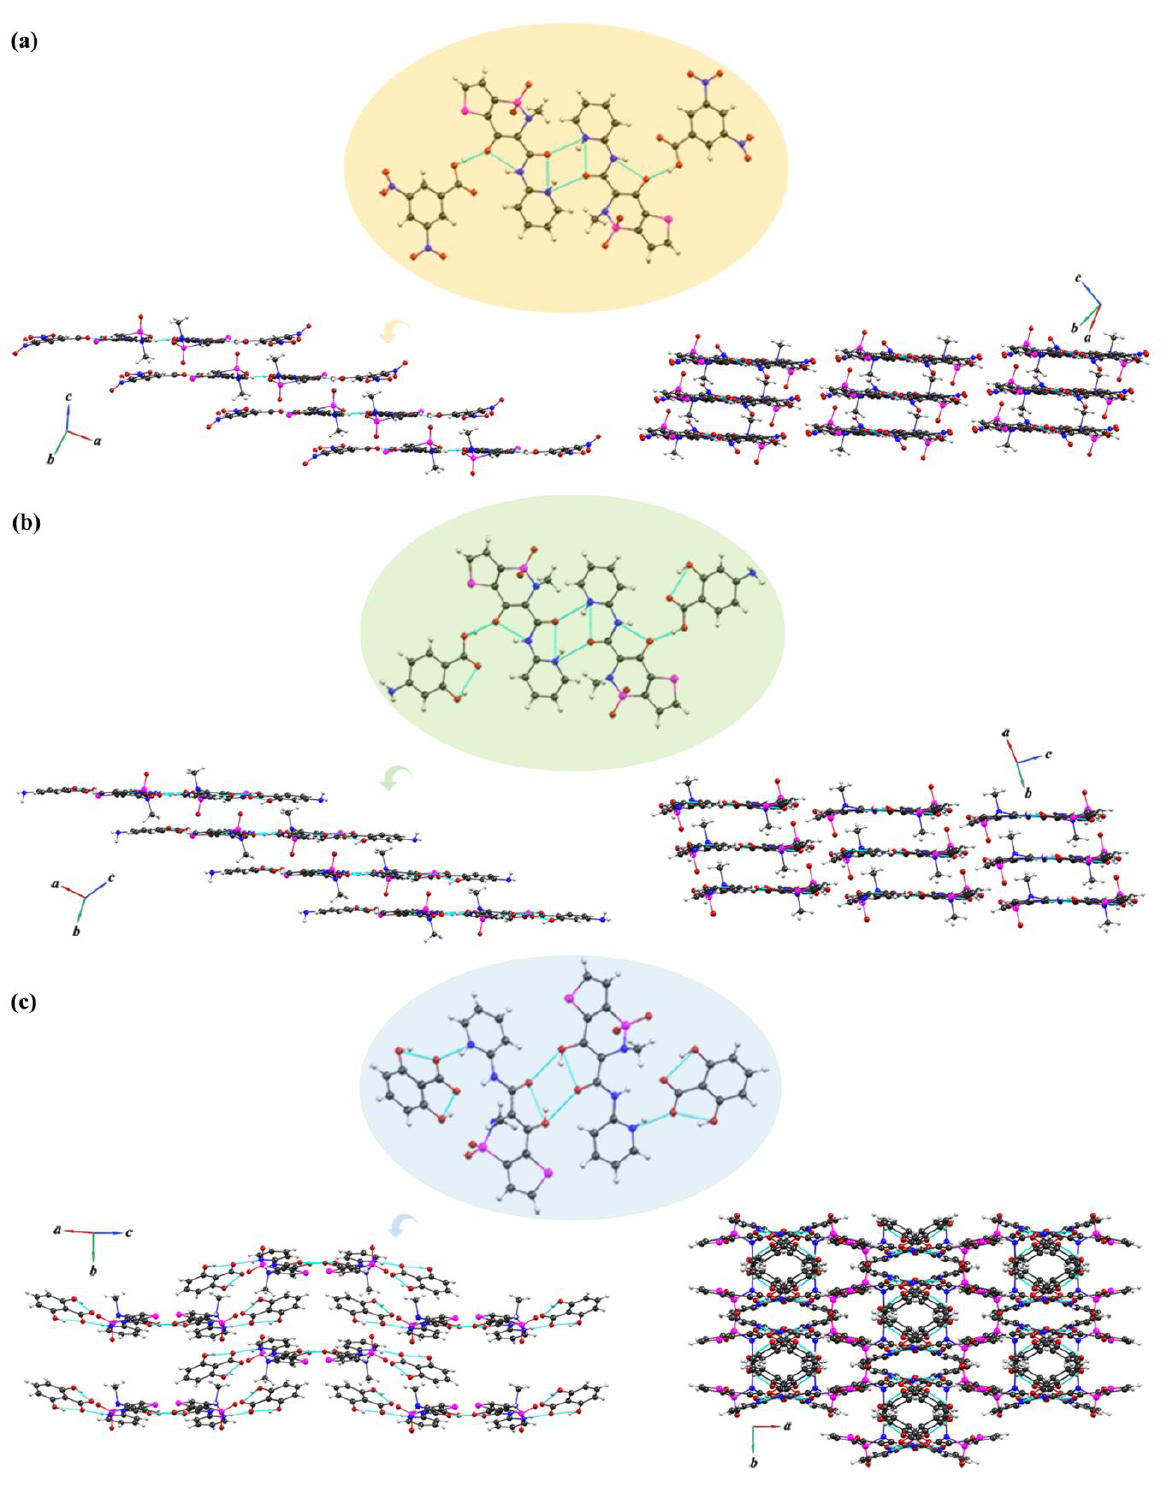
Figure 2. Hydrogen bond motifs and molecular stacking mode of ( a ) TNX-DNB, ( b ) TNX-PAS, and ( c ) TNX-DHB.